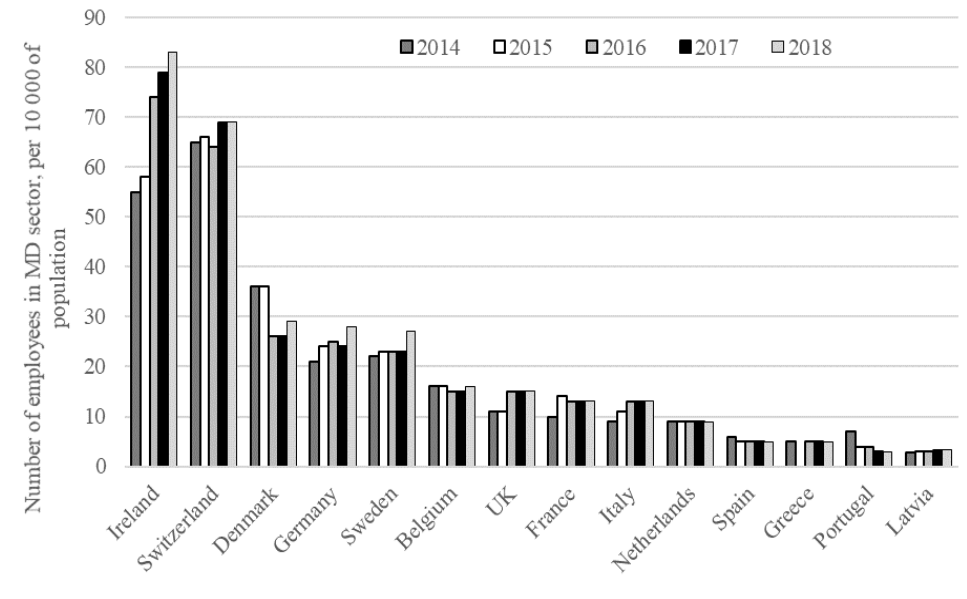
Fig. 3. Number of employees in the MD sector in Europe (developed by the author based on MedTech Europe